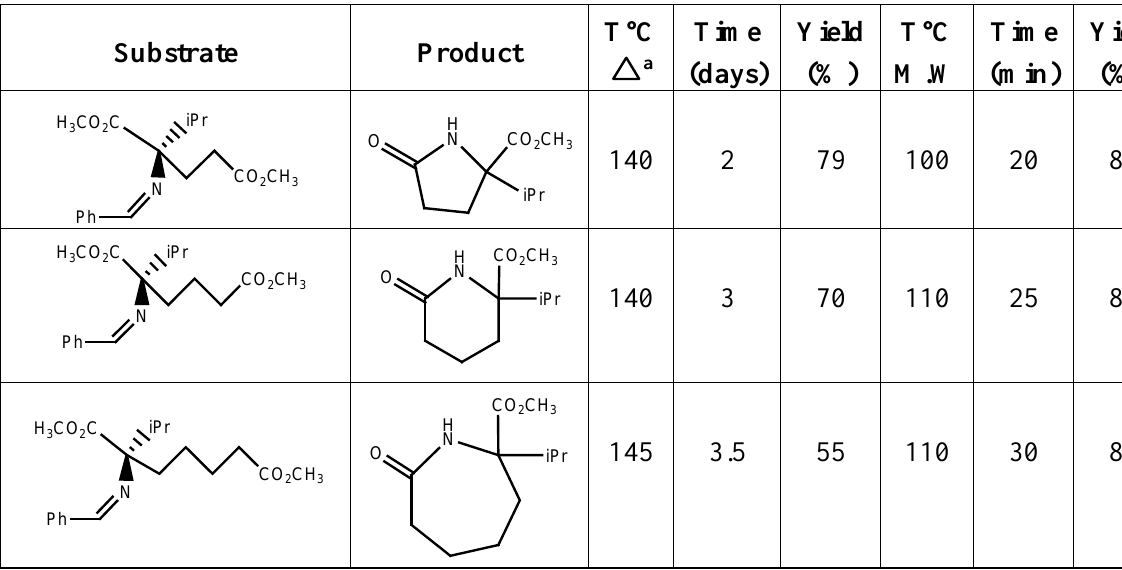
Table 5: Intramolecular cyclization of imines 1 with R = i